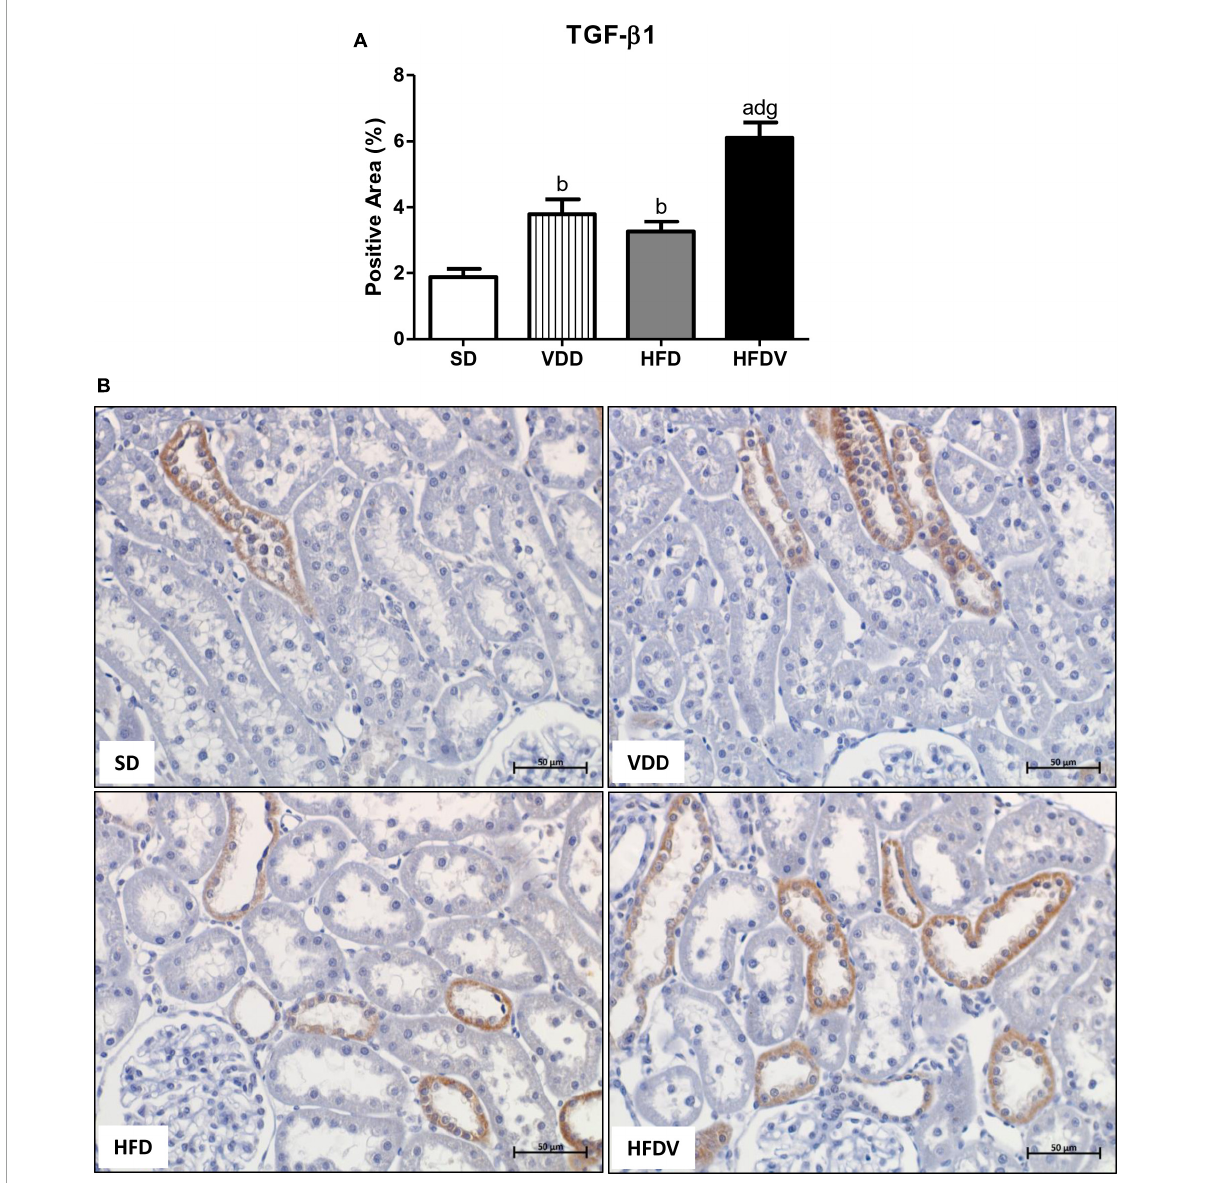
FIGURE7 Immunohistochemical analysis for transforming growth factor β 1 (TGF- β 1) expression in the renal cortex evaluated after the 90-day protocol in rats submitted to renal ischemia-reperfusion insult on day 45 treated with standard diet (SD), vitamin D-free diet (VDD), high-fat diet (HFD) or high-fat vitamin D-free diet (HFDV). (A) Bar graph of TGF- β 1 expression values. (B) Representative photomicrographs of immunostaining for TGF- β 1 in the renal cortex from an SD, VDD, HFD, and HFDV rat ( × 400). Data are mean ± SEM. a p < 0.001 and b p < 0.01 vs . SD; d p < 0.001 vs. VDD; g p < 0.001 vs.